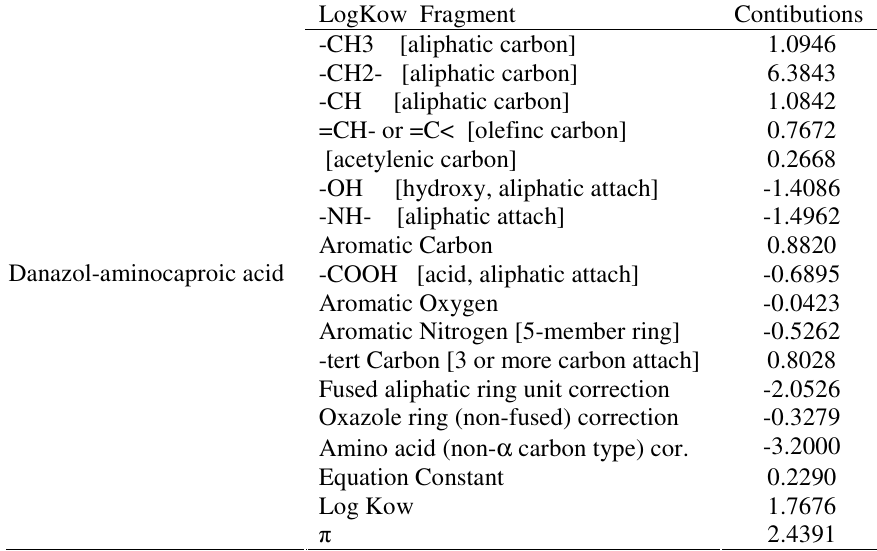
Table 2. Physicochemical parameters LogKow and π of danazol-aminocaproic acid